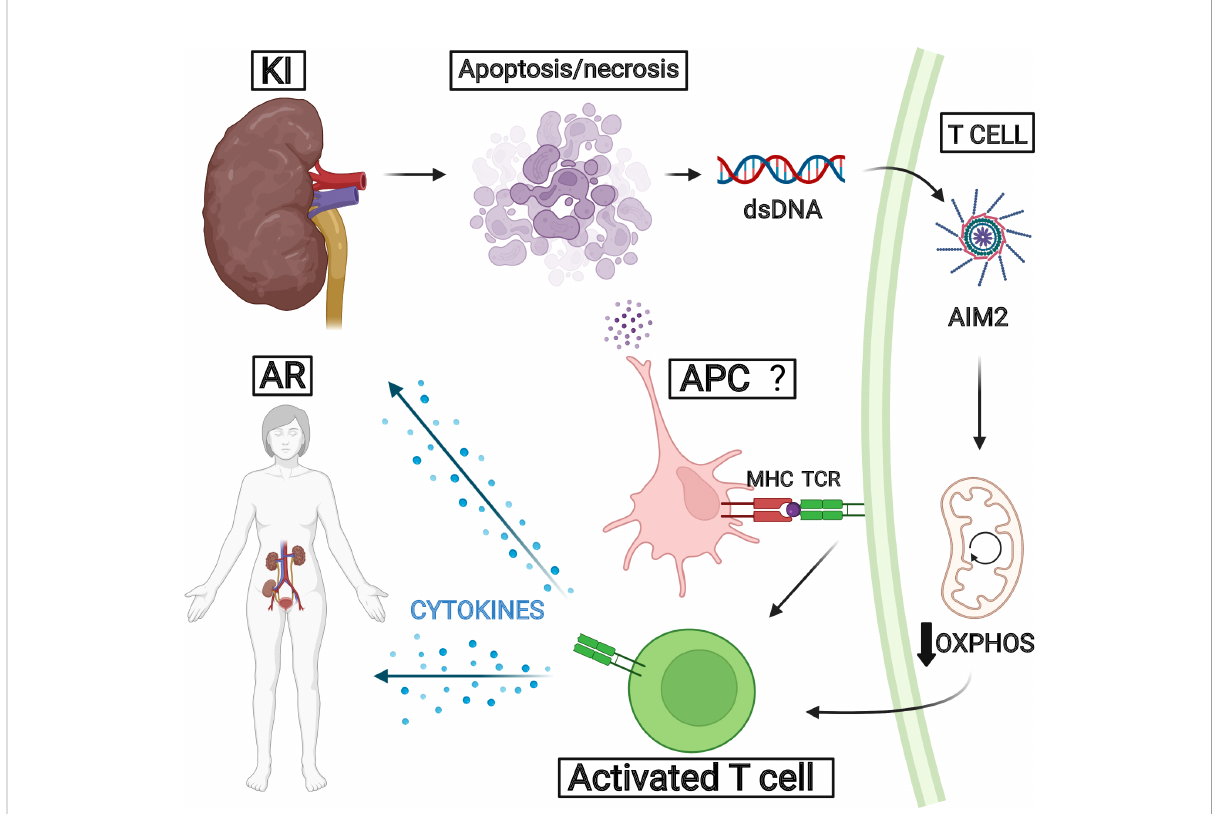
FIGURE 8 Proposed pathway for AIM2 in acute rejection. We hypothesize that kidney injury secondary to transplantation could trigger tissue apoptosis and necrosis, leading to donor dsDNA release. This molecule could be recognized by AIM2 collaborating for T-cell activation related to OXPHOS decrease. The in fl ammatory processes reinforce kidney injuries and favor acute rejection